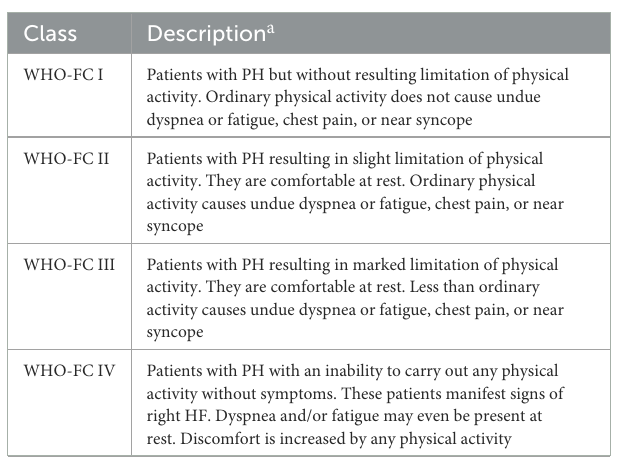
FrontiersinCardiovascularMedicine